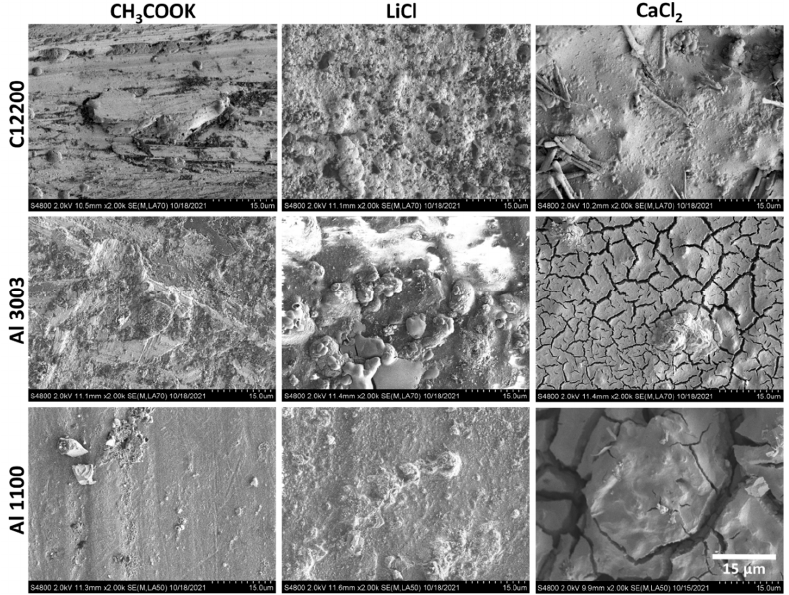
Figure 7. FESEM top-view micrographs of the WE surfaces after electrochemical corrosion experi- ments.